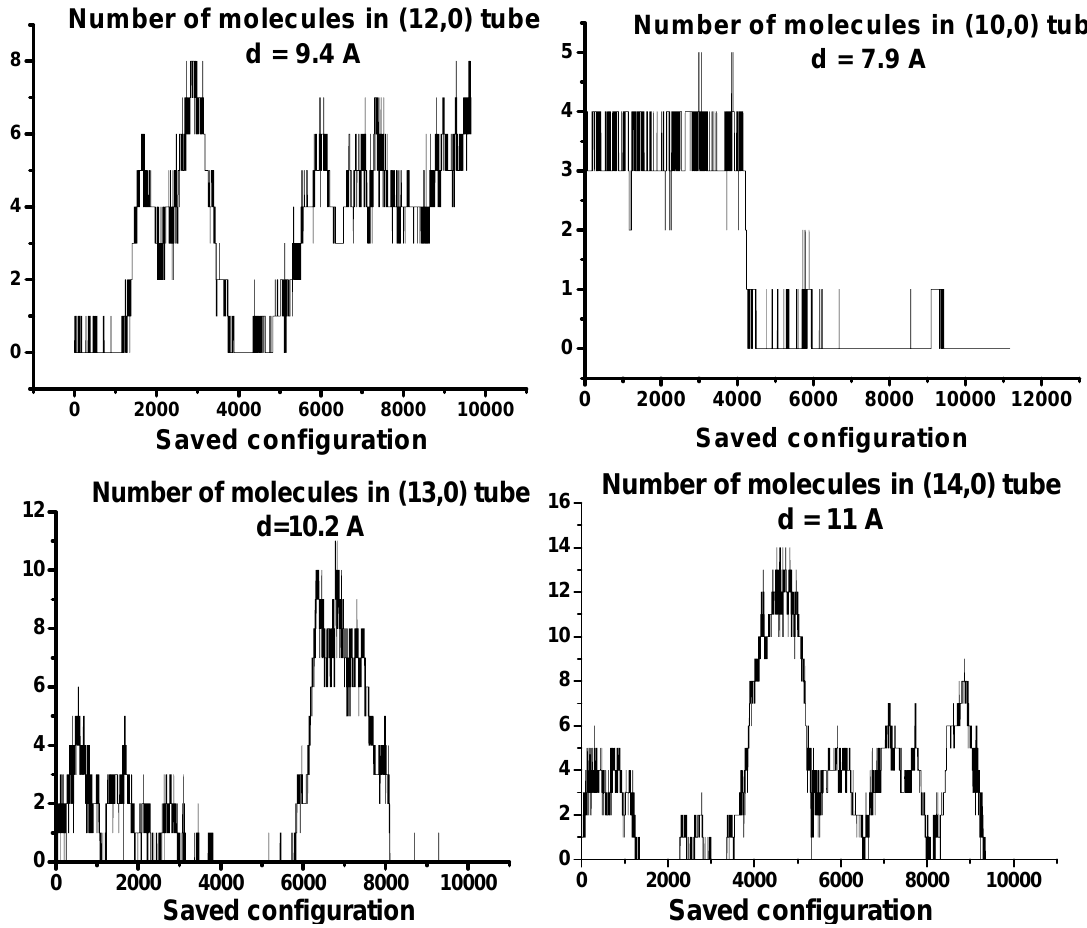
Figure 3. Dependencies of amount of inner water content on the tubes' diameters and on the length of Markovian chains. Graphics concern zigzag